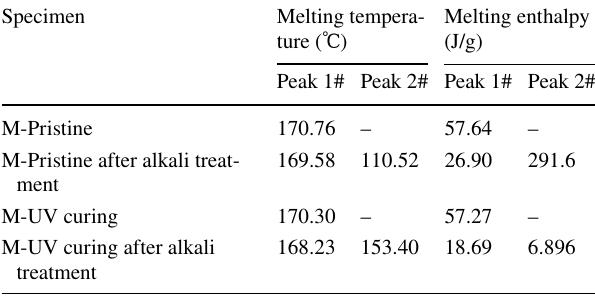
Table 2 The effect of NaOH treatment on melting temperature and melting enthalpy Specimen